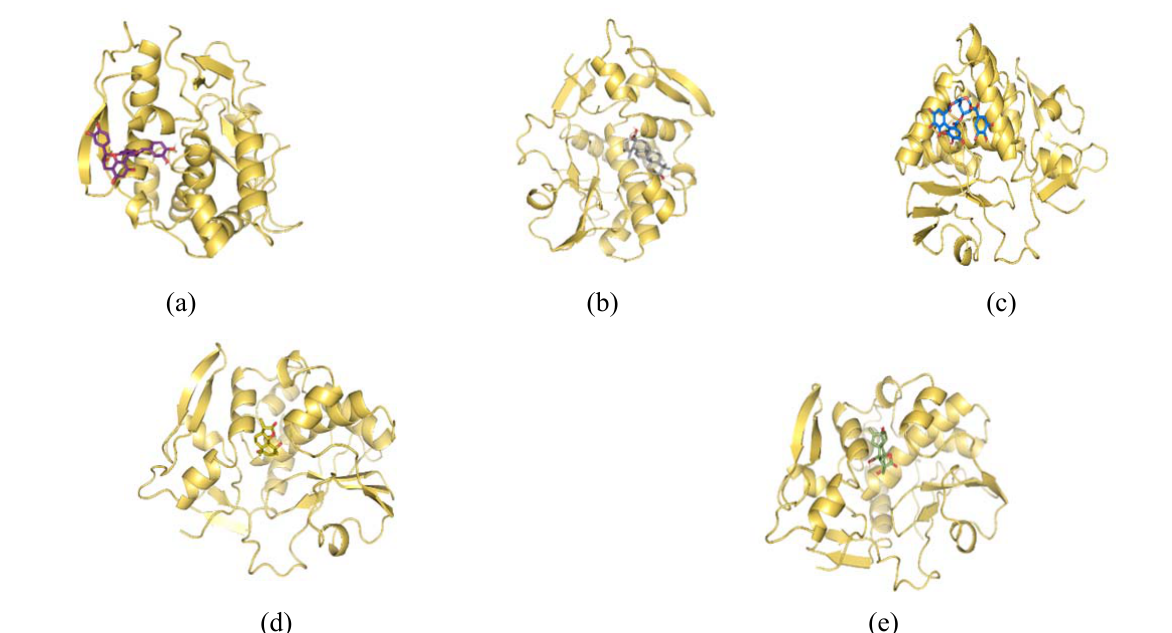
Figure 1. 3D visualization in PyMOL 2.5 (by Schrödinger) to show the interaction between abrin and (a) procyanidin B4; (b) ursolic acid; (c) corilagin; (d) vulgarine; and (e) glibberellic acid as virtual screening result using AutoDock Vina.